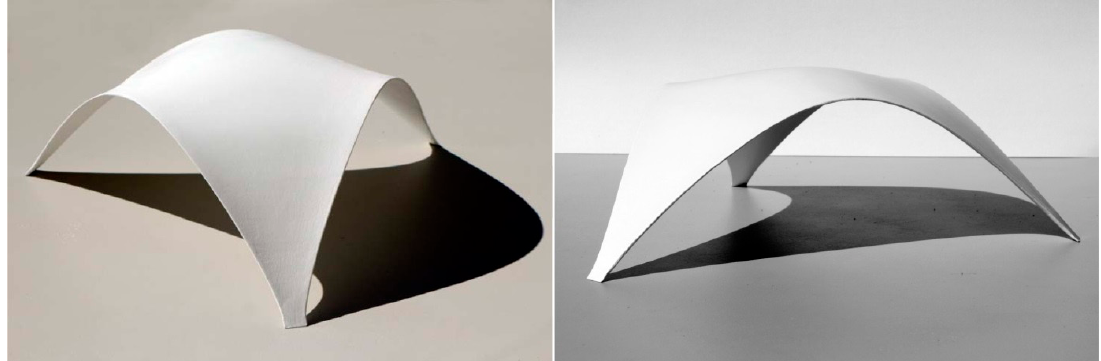
Figure 13. The free shape shell ‘H800N3’ under natural light (22 of August 2014, 38°38 ′ 28.61 ″ N–9°12 ′ 44.64 ″ O, altitude: 95 m, time: 5:00 p.m.).